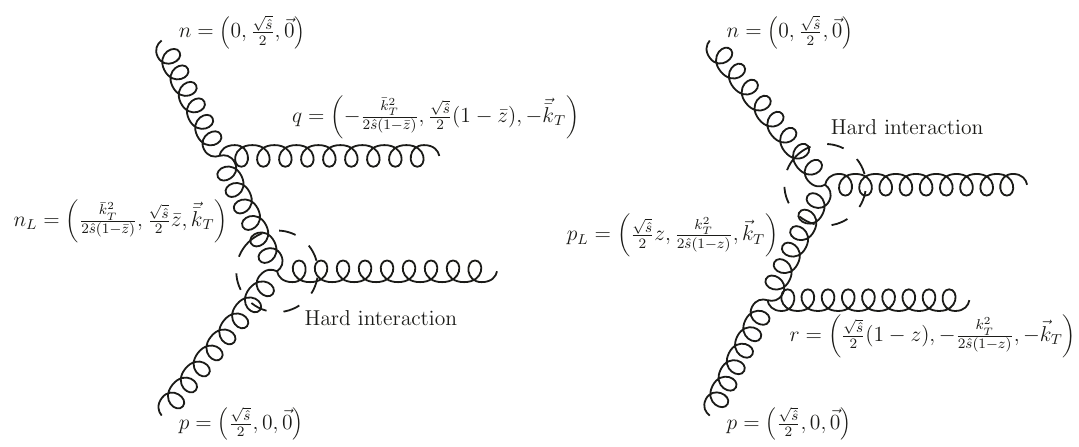
Figure 5 . Feynman diagrams giving the LL x contributions to the single emission process in the small- x limit. The relevant kinematics is displayed in terms of light-cone Sudakov components.